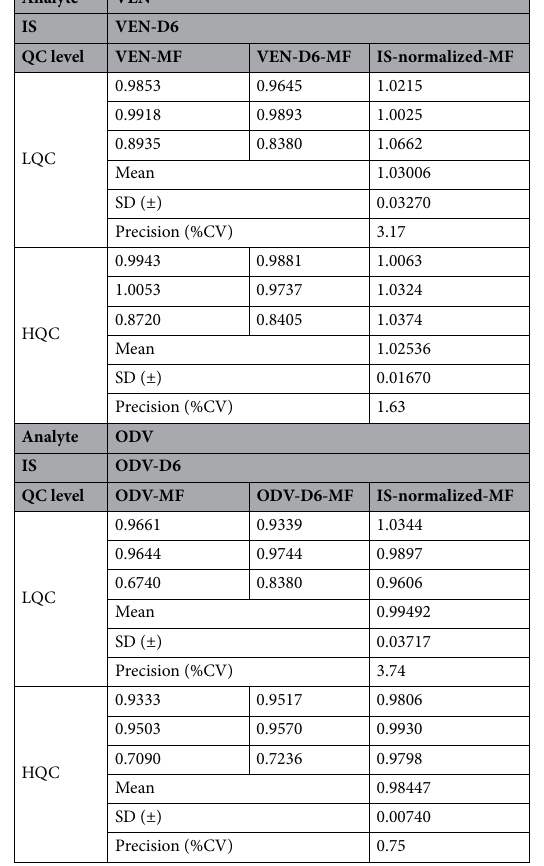
Table 7. Matrix effect data for VEN and ODV in three different lots of rabbit